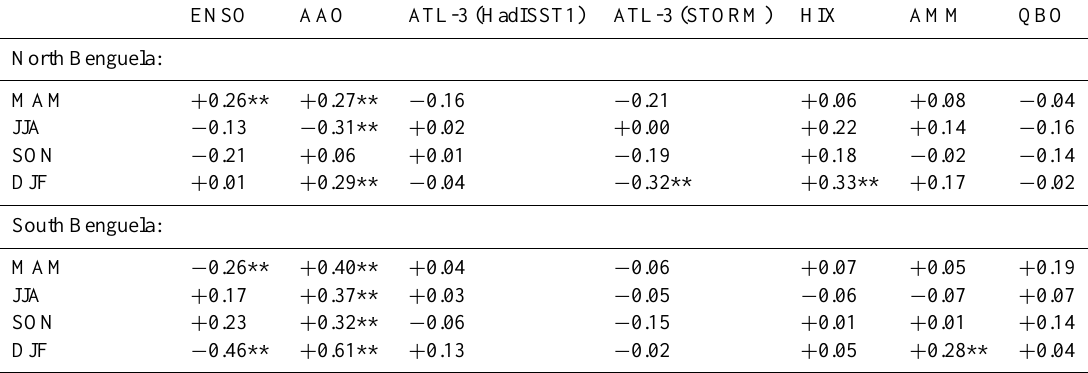
Table 3. Correlation coefficients of the upwelling indices derived from the vertical velocity of STORM of North Benguela and South Benguela with ENSO, AAO, ATL-3 of HadISST1, ATL-3 of STORM, HIX, AMM, and QBO, significant correlations are highlighted by **. ENSO AAO ATL-3 (HadISST1) ATL-3 (STORM) HIX AMM QBO North Benguela: MAM + 0.26** + 0.27** − 0.16 −